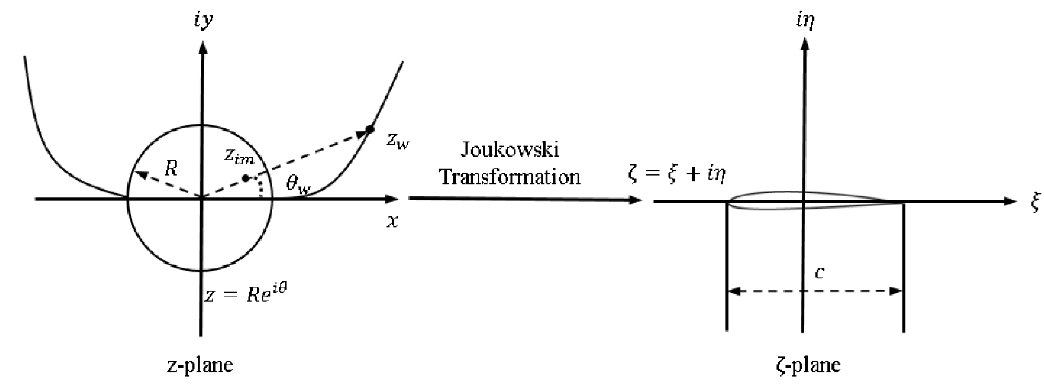
Figure 3. Joukowski transformation of a circle to an airfoil.